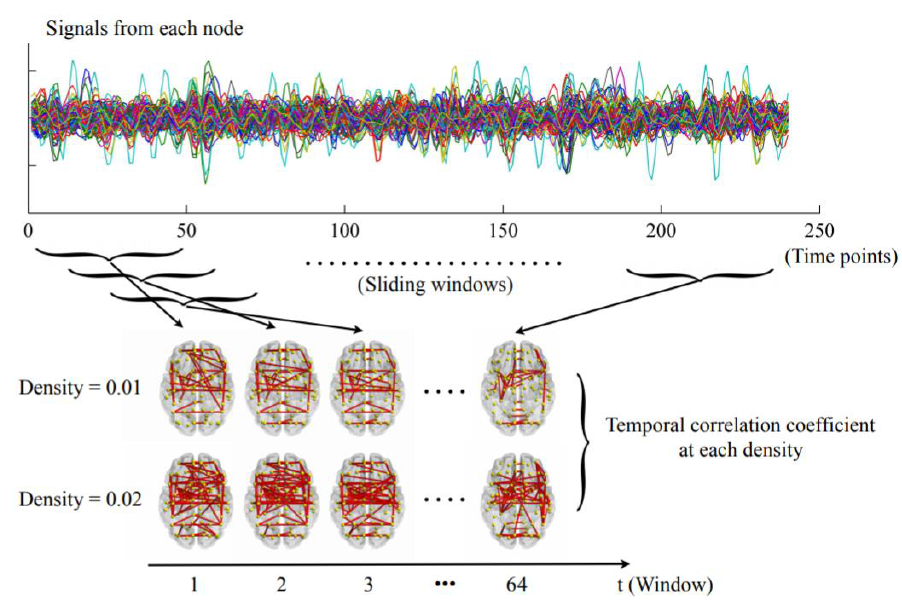
Figure 1. The steps for constructing dynamic networks and calculating temporal correlation coefficients as detailed in the Materials and Methods section (only the densities of 0.01 and 0.02 were presented here for visualization purposes).